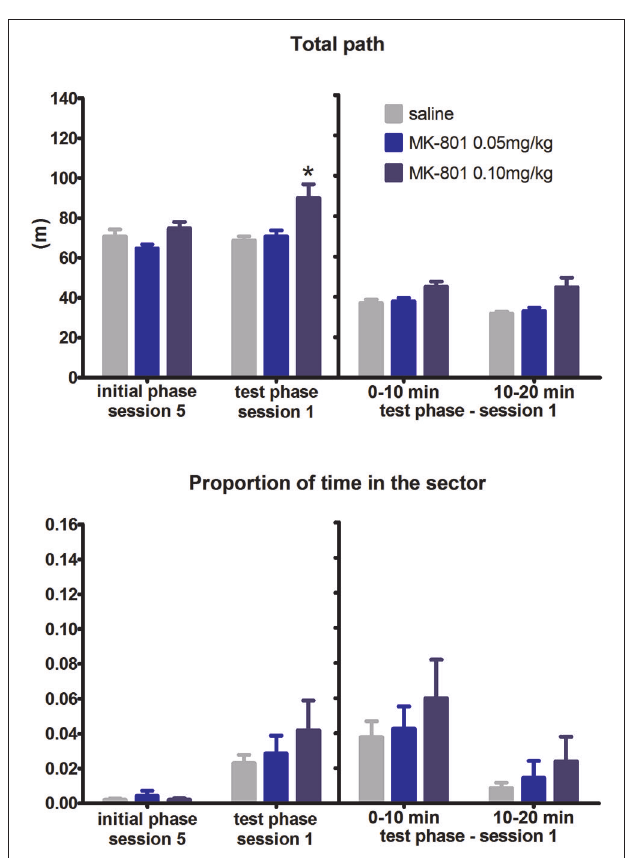
FIGURE 3 | Performance of the rats in condition 2 (reversal within RF) . Upper graph indicates total path elapsed during the last session of the initial phase, first session of the test phase, and its split into two 10 min segments (group means ± SEM). Lower graph shows proportion of session time spent in the prohibited sector. Difference between the session 1 of the test phase and the session 5 of the initial phase were computed as difference scores and the resulting statistics is provided. * P < 0.05 compared to saline group.